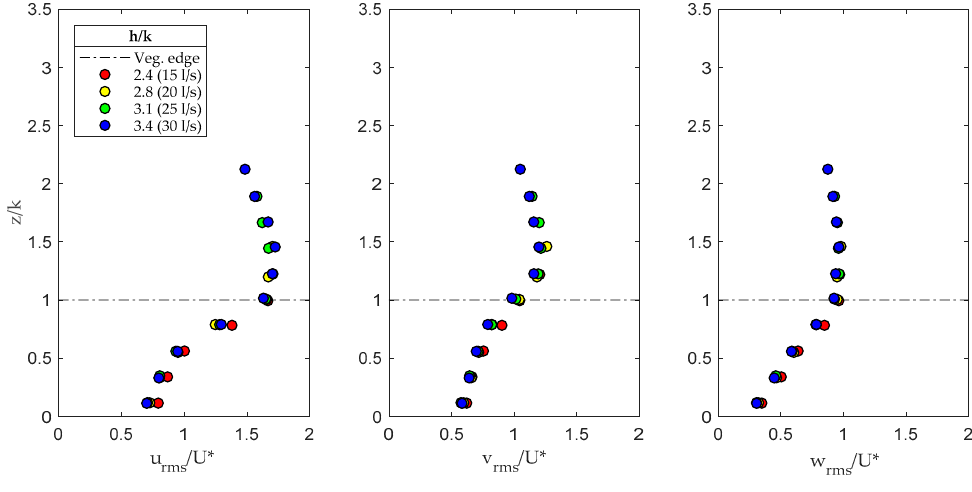
Figure 4. Turbulent intensities in the three directions x, y, and z.